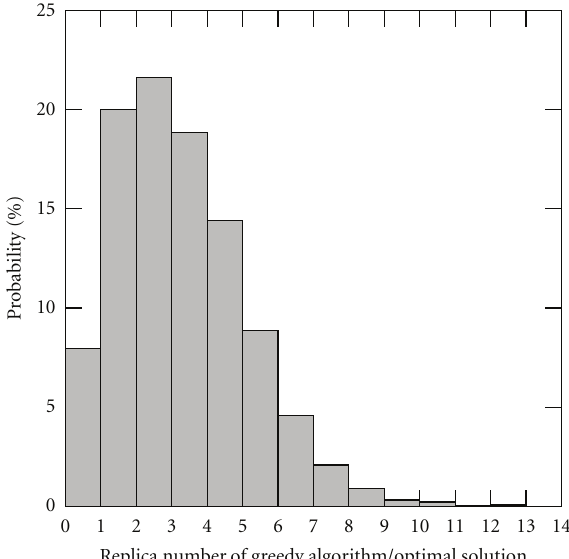
Figure 3: Probability of approximate ratio of the greedy algorithm, where the number of nodes is 32, and the average node degree is 3, the cost of a link is uniformly distributed between 1 and 15, and the number of simulations are 5000.